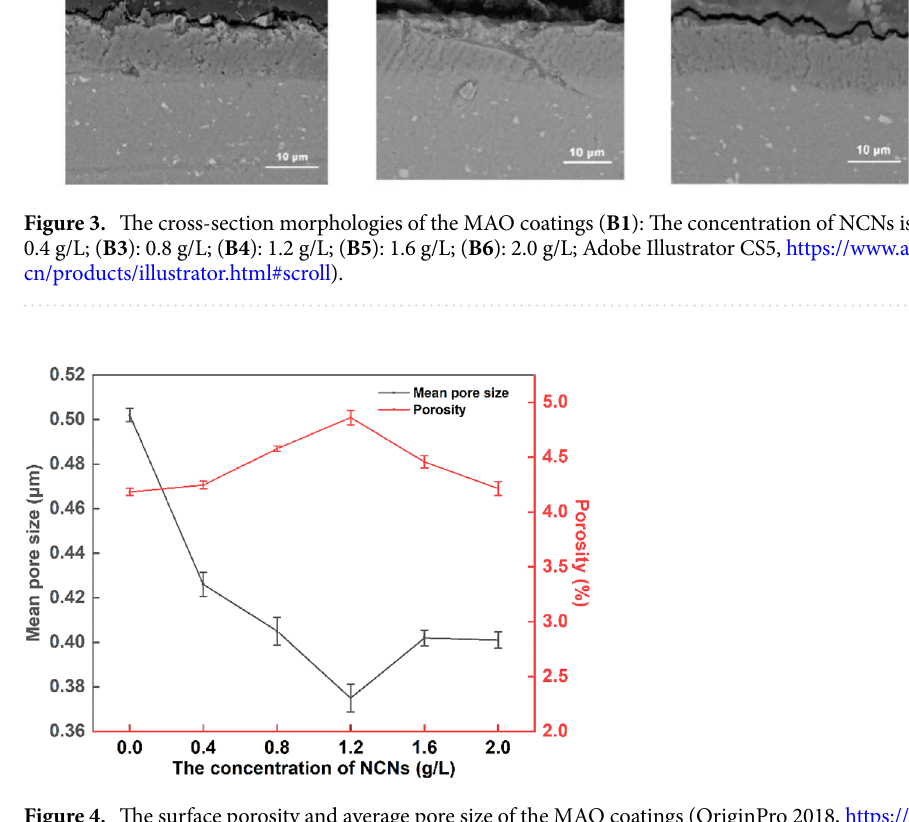
Figure 4. The surface porosity and average pore size of the MAO coatings (OriginPro 2018, https:// www. origi nlab. com/ index. aspx? go= Produ cts/